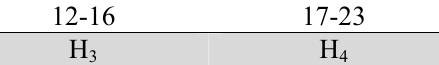
Different categories of the proposed model